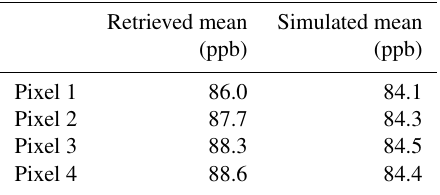
Table 2. Mean values of MOPITT X CO retrievals, colocated with AirCore measurements and separated by pixel, compared to the simulated X CO from applying MOPITT averaging kernels to Air- Core profiles for 22